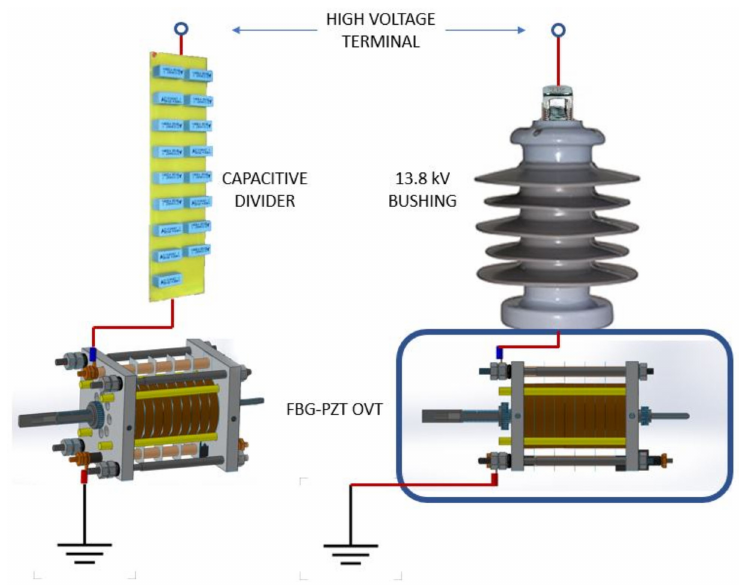
Figure 19. ( Left ) A high voltage capacitor stack was used to lower the applied voltage to the OVT. ( Right ) The proposed assembly to allow the OVT to be used in field measurements with the capacitor stack inserted inside a 13.8 kV bushing, whereas the OVT is protected inside a IP65